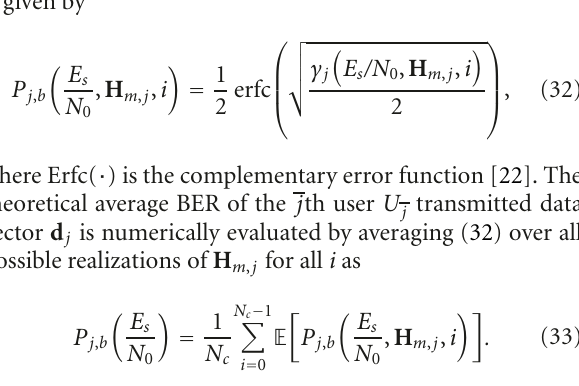
Figure 6: Impact of σ 2